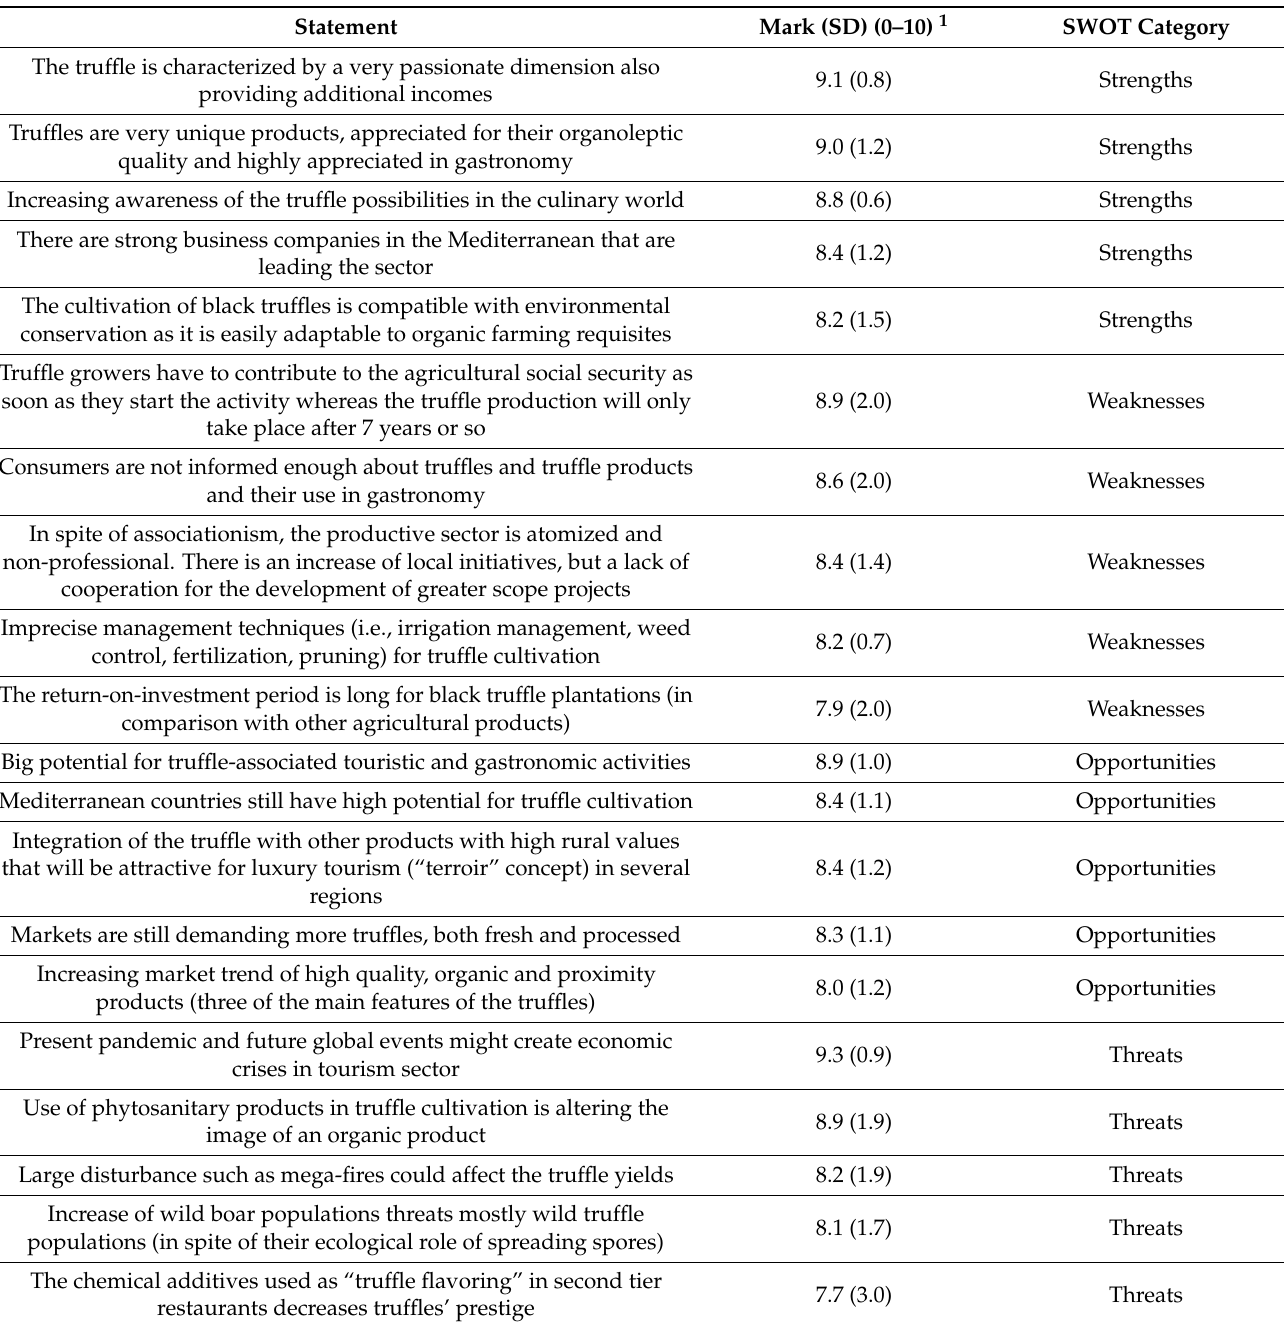
Table 2. Top five ranked strengths, weaknesses, opportunities, and threats identified by the truffle expert panel at the end of the second